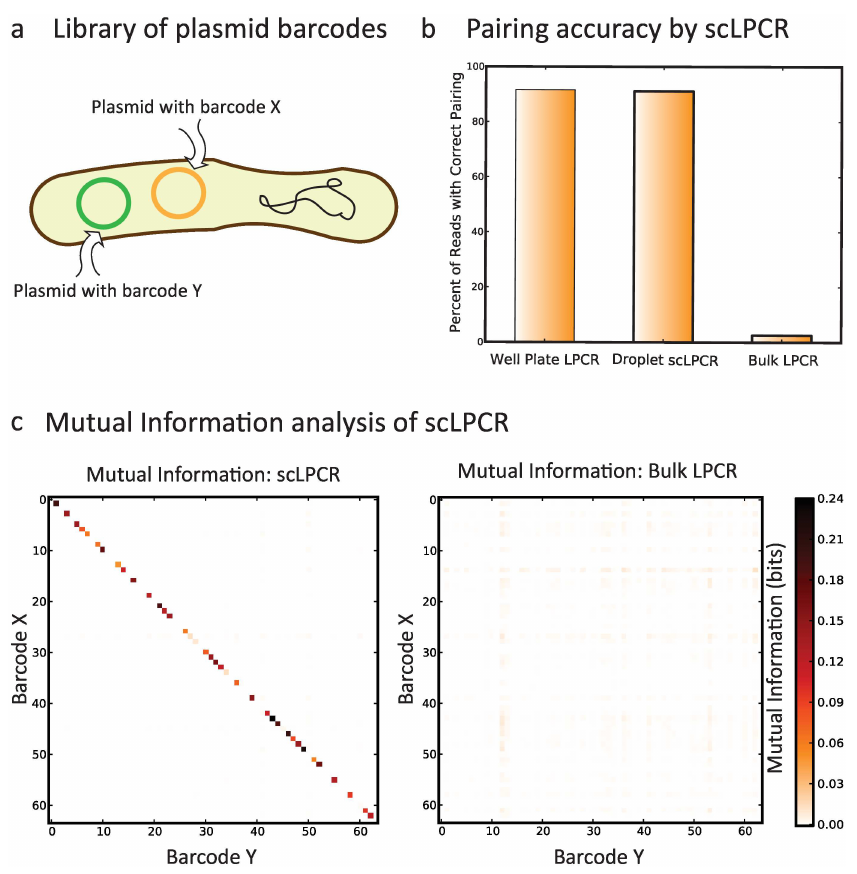
Fig 3. Screening complex libraries with droplet sc-Seq. (a) Library of E . coli containing64 strains, each containing a pair of known barcodes(denotedX and Y) locatedon separateplasmids. (b) The accuracy of barcodeX and Y pairingfrom NGS (as percent of sequencing reads that report a correct X/Y pair) is the same when using linkagePCR on isolated strains (well plate LPCR) or when using singlecell linkagePCR in droplets(Droplet scLPCR), while linkagePCR from all strains in bulk (Bulk LPCR) yields mostly randomX/Y pairs. (d) The amount of mutual information betweenspecific X/Y barcodepairs in the NGS data shows strong correlationsalong the diagonal,representing true X/Y pairs. In the same data for librariesfrom linkagePCR in bulk there is no correlationbetweenrepresentedbarcodes.